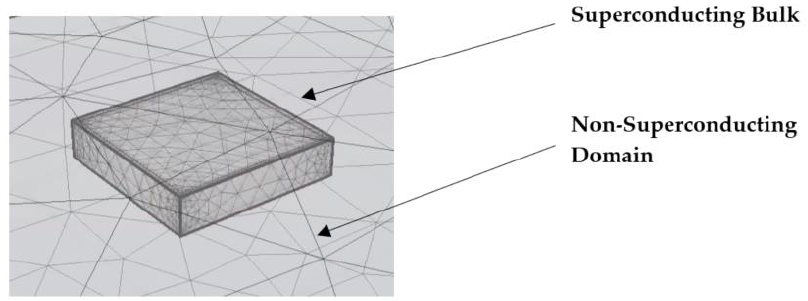
Figure 3. Meshed model of Superconducting Bulk sample.